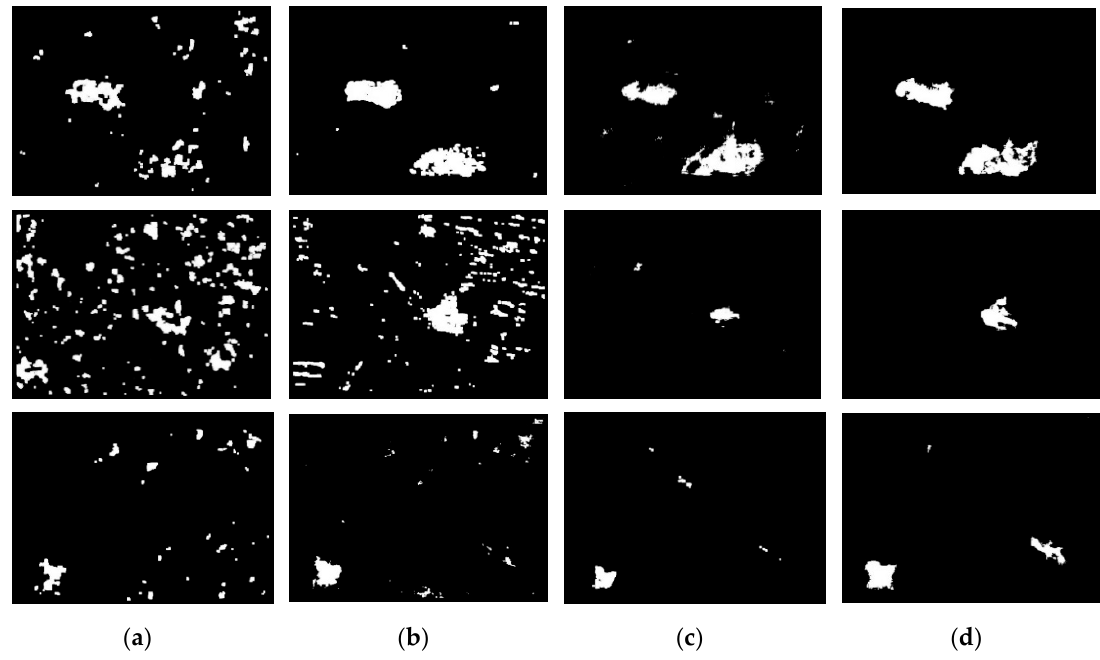
Figure 8. Receiver operating characteristic (ROC) for ( a ) Area 1, ( b ) Area 2, and ( c ) Area 3.